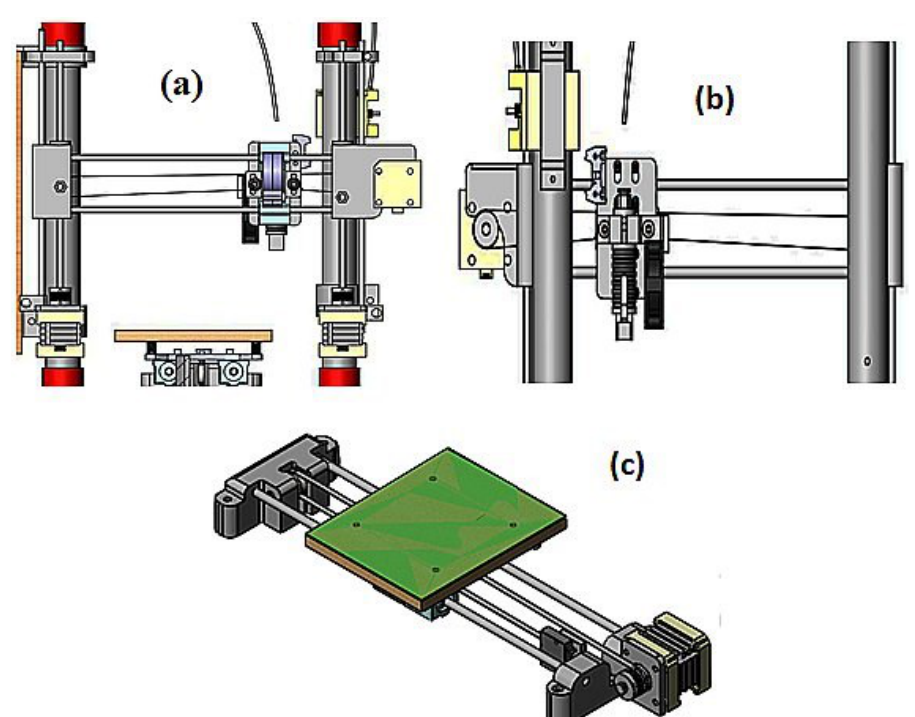
Figure 1. Assembly CAD Model- ( a ) z-axis Movement, ( b ) x-axis Movement, and ( c ) y-axis Movement.